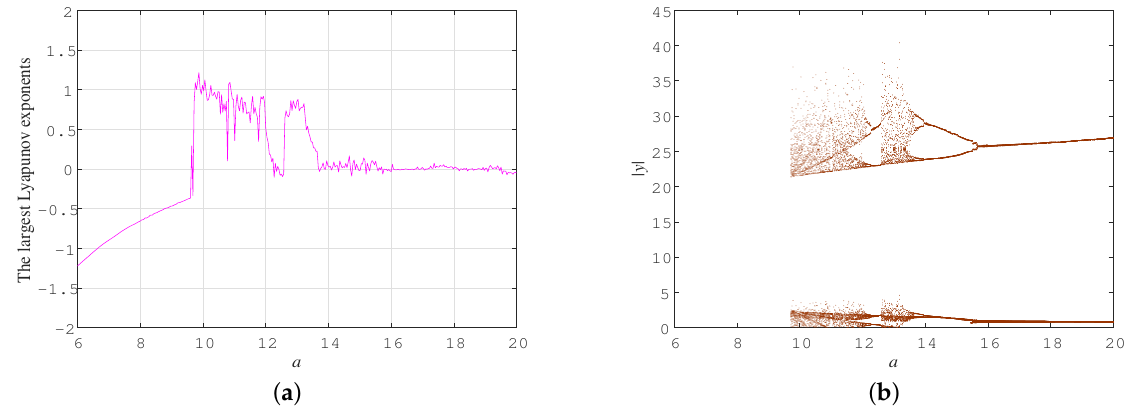
Figure 7. Parameter values ( b , c , k ) = ( 100,11.2, − 0.2 ) , largest Lyapunov exponent spectrum ( a ), and bifurcation diagram ( b ) of system (1) for a ∈ [ 6,20 ]